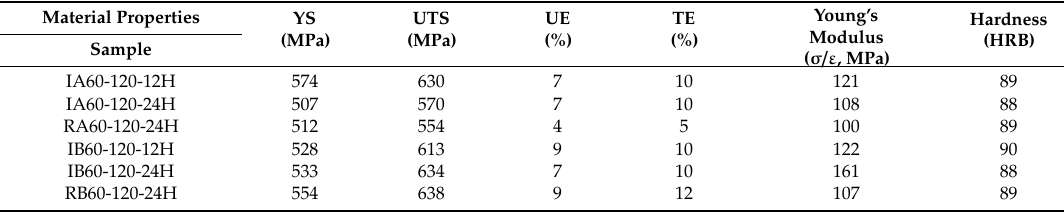
Table 6. Specific tensile strength, elongation, and hardness from Figure 10.